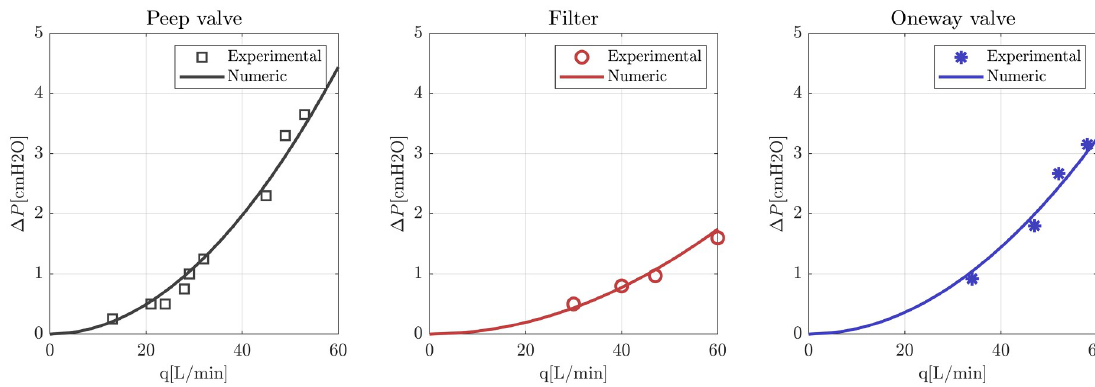
Fig 13. Characteristic curves of one-way valves, filters and PEEP valve.